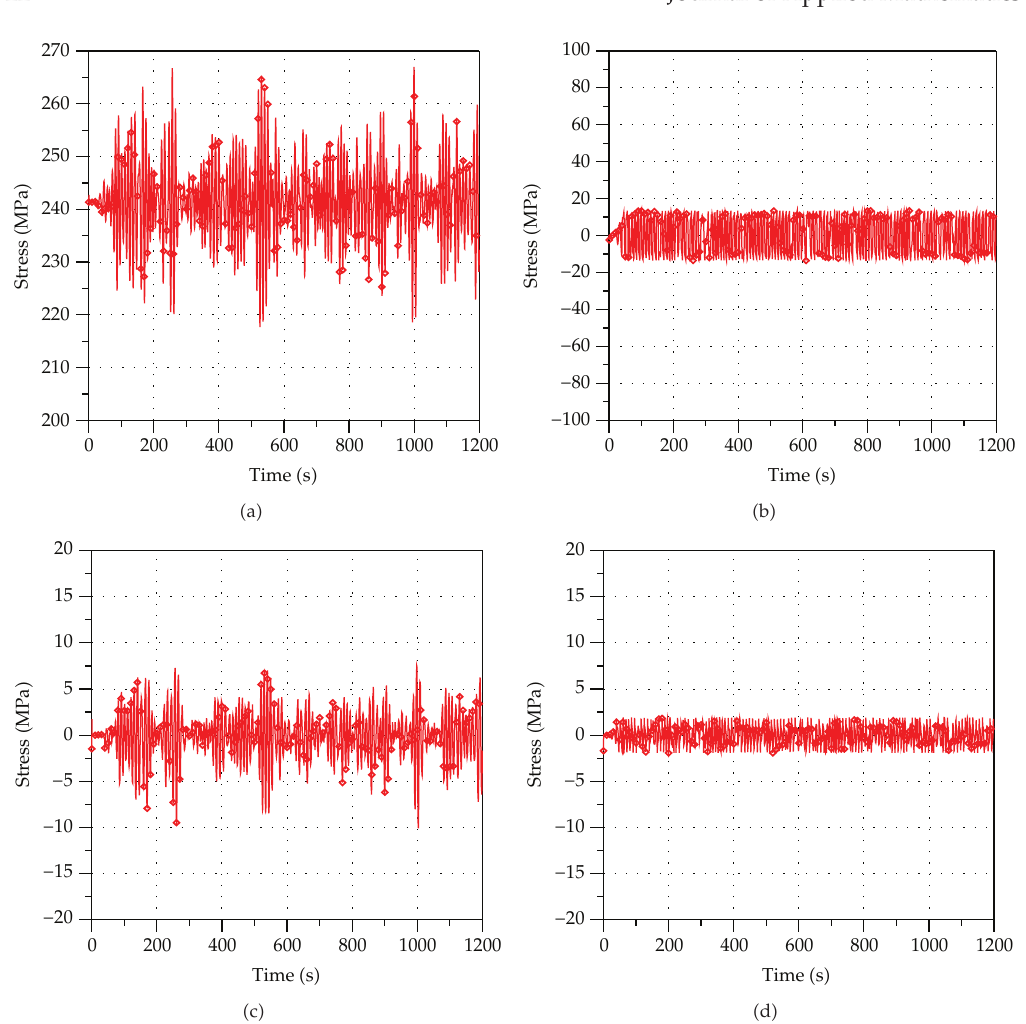
Figure 10: Time histories of stresses in wire 12 (cid:3) corner with the highest fatigue damage (cid:4) of the outer tensile armor: (cid:3) a (cid:4) axisymmetric stresses; (cid:3) b (cid:4) normal friction stresses; (cid:3) c (cid:4) normal bending stresses; (cid:3) d (cid:4) transverse bending